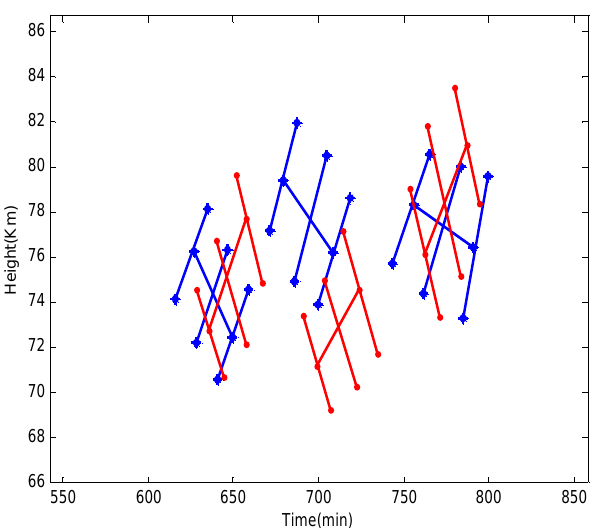
Fig. 2. Phase lines (along the patches) and energy lines (across the patches) of upward wave packets (from Fig. 1a, marked by red lines) and downward wave packets (from Fig. 1b, marked by blue lines). Overlaps of upward waves and downward waves clearly existed in the leftmost and the rightmost wave packets.